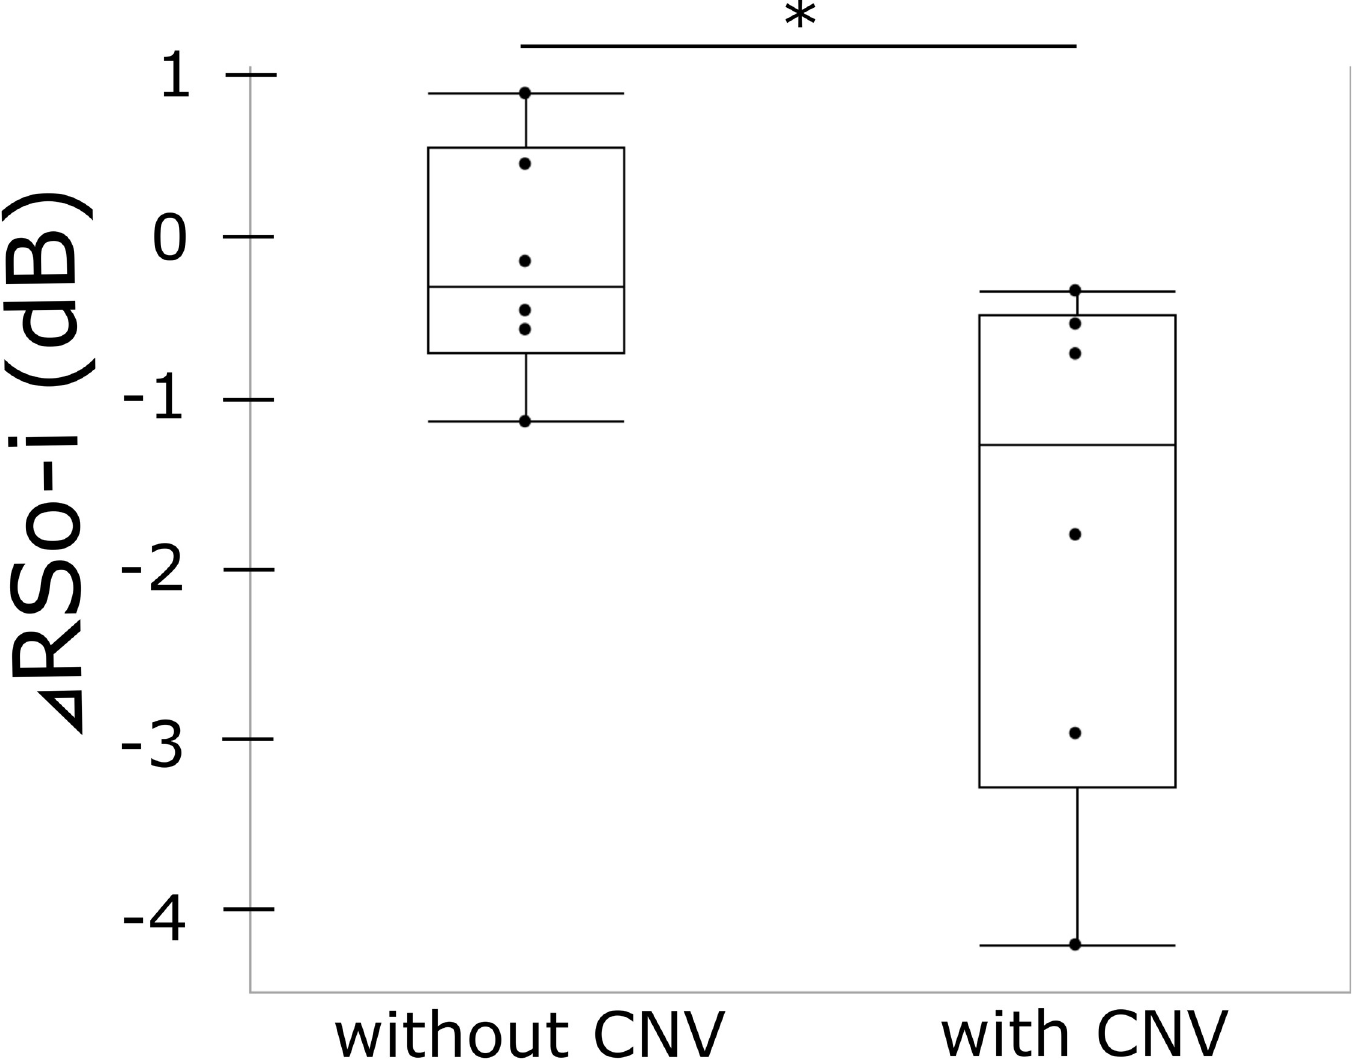
Fig 2. Difference in retinal sensitivity within and outside CVH ( ⊿ RSo-i) in patients with CNV (n = 6) and without CNV (n = 6). ⊿ RSo-i was significantly better in eyes without CNV than in eyes with CNV (p =